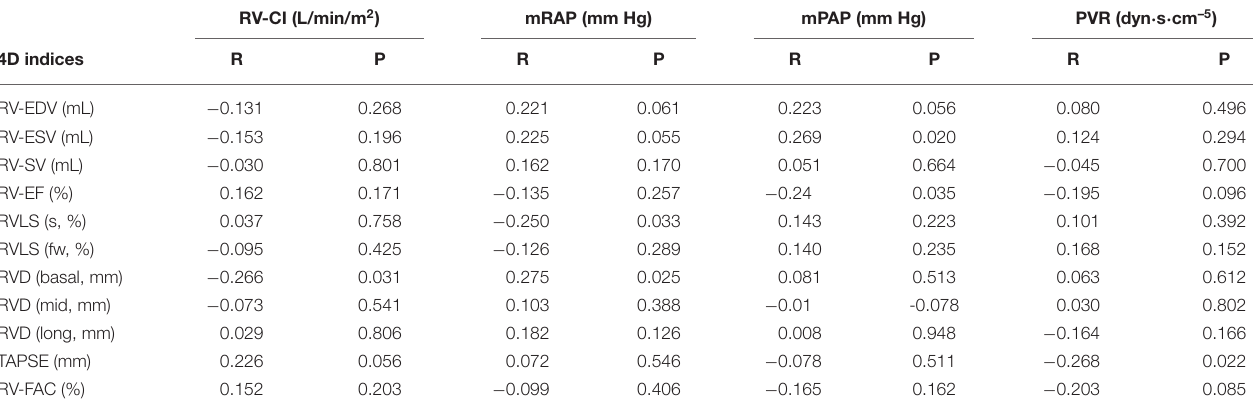
TABLE 3 | Correlation between RHC and 4D auto-RVQ indices in all PHTN cases ( n =